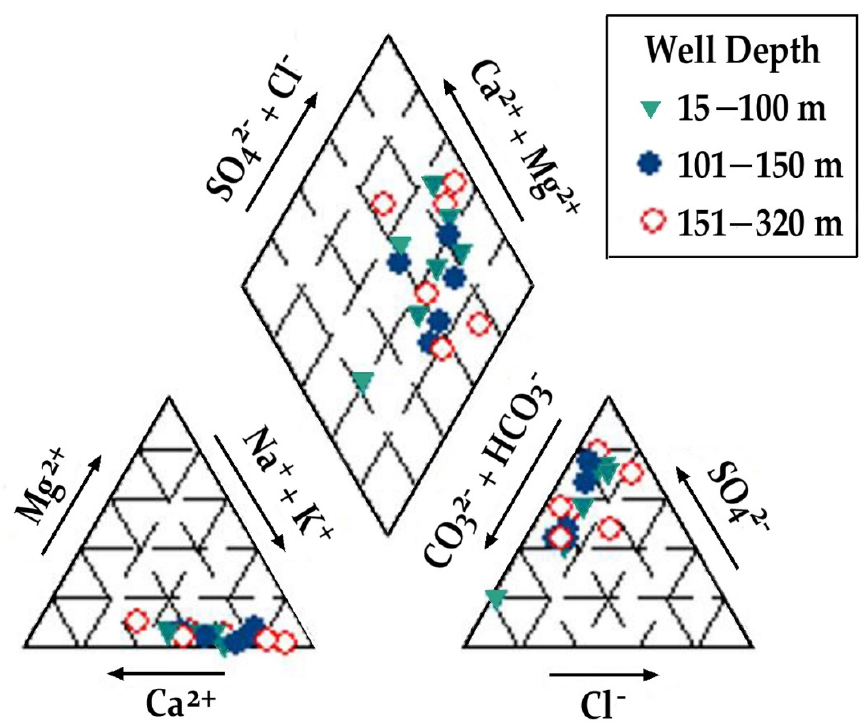
Figure 2. Piper diagram showing major ion concentration of the sampled wells.